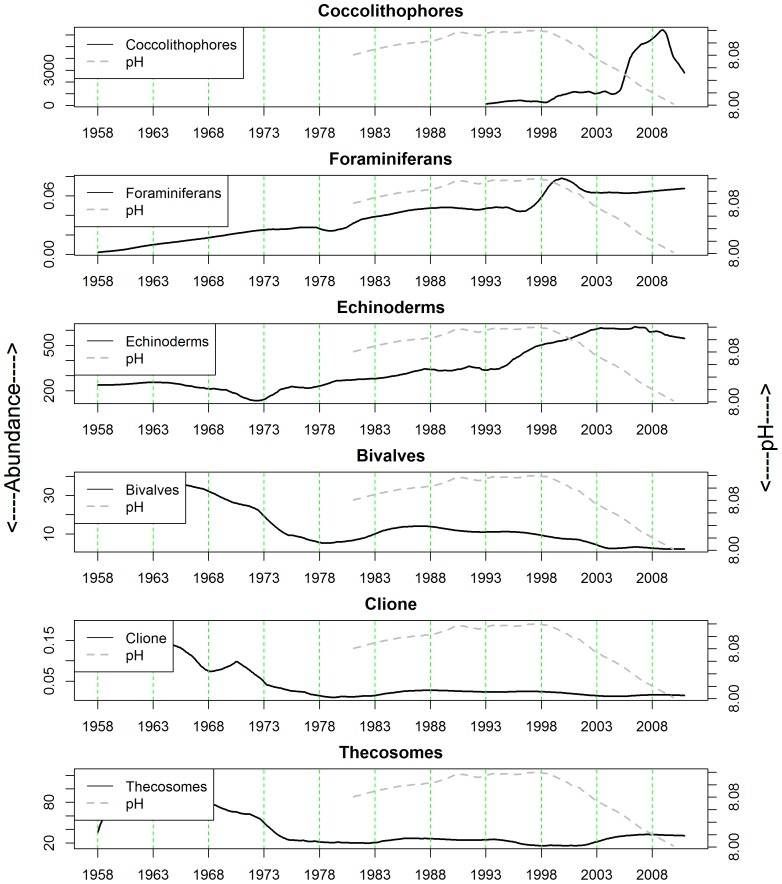
Long-term trends in the abundance of calcifying plankton between 1958 and 2010.The trends were estimated using Friedman's super-smoother in which abundance is modeled as a function of long-term trend.